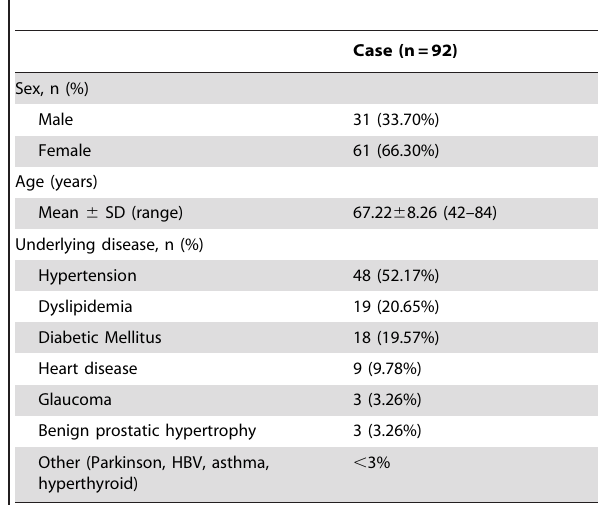
Table 1. Demographic data.